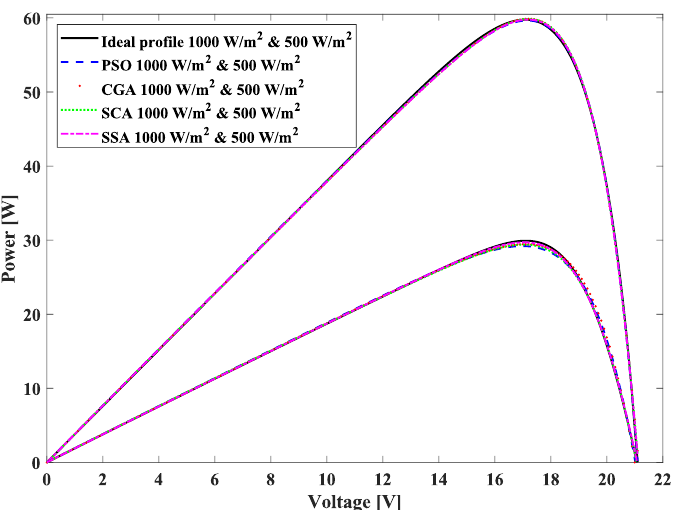
Figure 8. Simulation performed with the parameters found for the lowest errors in the MSX60 PV panel under the 1000 W/m 2 and 500 W/m 2 irradiance levels.